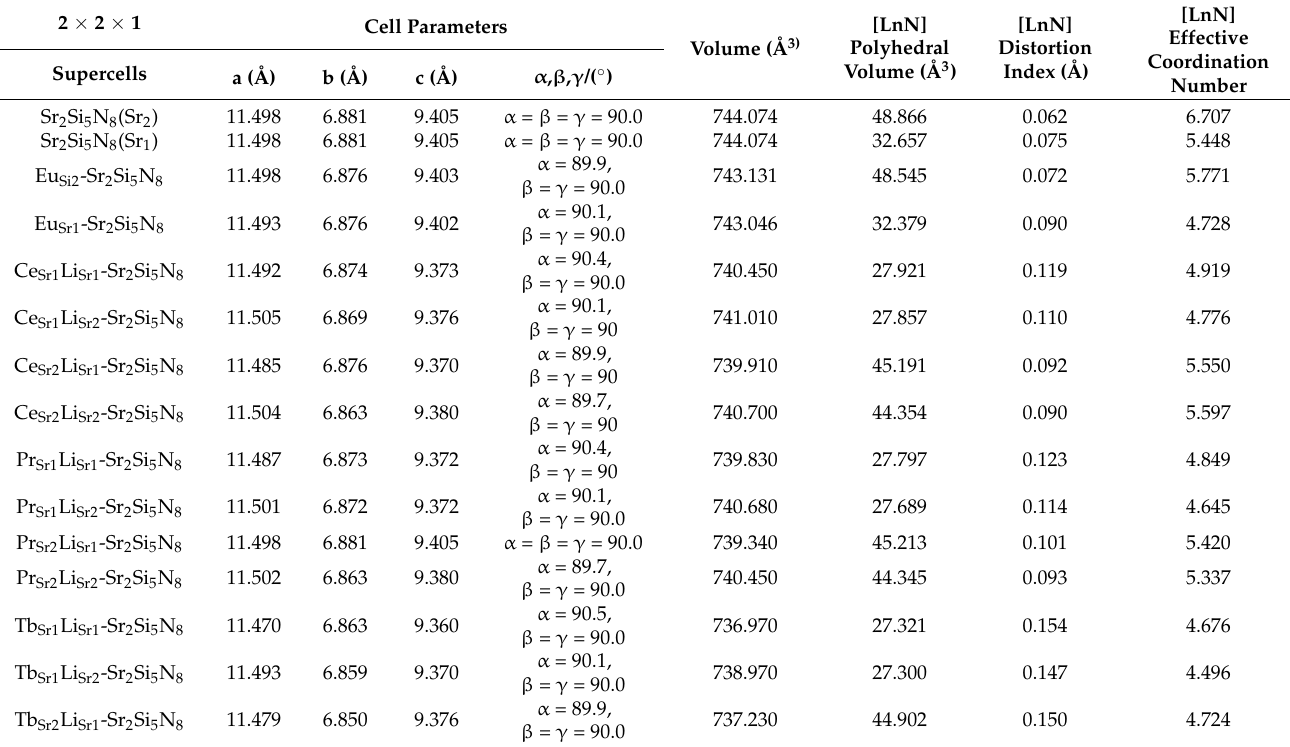
Table 1. Cell parameters and [LnN] polyheral structures of Sr 2 Si 5 N 8 and Sr 2 Si 5 N 8 doped by Ln (Ce 3+ , Pr 3+ , Tb 3+ )/Li + , Eu 2+ . 2 × 2 × 1 Cell Parameters